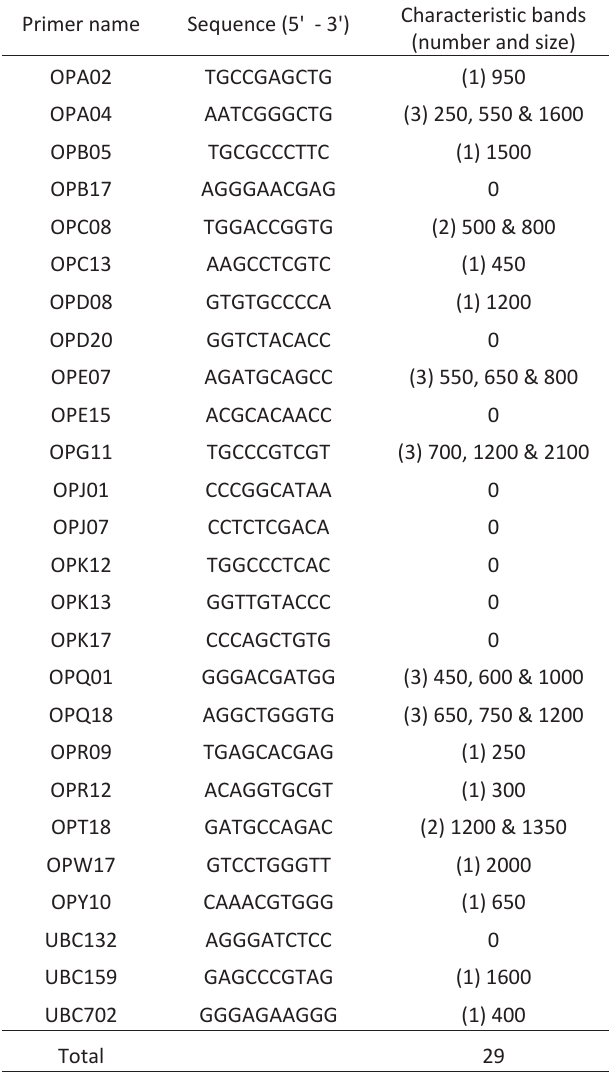
Table 1 - Characteristic bands identified for the four tested cot- ton varieties using 26 RAPD